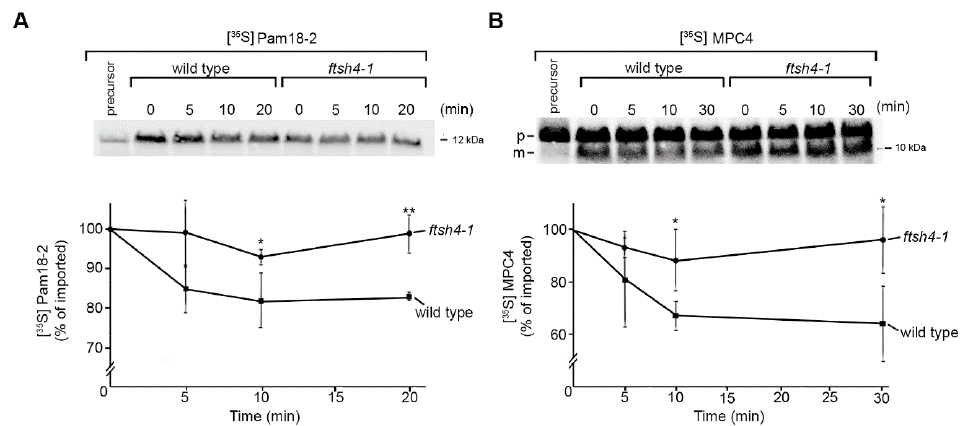
Figure 3. Novel proteolytic substrates of FTSH4 protease. ( A ) Degradation of Pam18-2 by FTSH4 following its in vitro import into mitochondria. Radiolabeled Pam18-2 was imported into mitochondria derived from either wild type or ftsh4-1 plants. The stability of newly imported precursor upon further incubation at 26 ◦ C was analyzed by SDS-PAGE and autoradiography. Quantification of [ 35 S] Pam18-2 in mitochondria is represented in the lower panel. Newly imported Pam18-2 was set to 100%. Data represent mean ± SD of three independent experiments. * p < 0.02 and ** p < 0.003 ( t -student test); ( B ) Degradation of MPC4 processed form by FTSH4 following its in vitro import into mitochondria. Radiolabeled MPC4 was imported into mitochondria derived from either wild type or ftsh4-1 plants. The stability of newly imported MPC4 upon further incubation at 26 ◦ C was analyzed by SDS-PAGE and autoradiography. Quantification of [ 35 S] MPC4 processed form in mitochondria is represented in the lower panel. Newly imported MPC4 was set to 100%. Data represent mean ± SD of three independent experiments. * p < 0.05 ( t -student test). m—MPC4 processed form, p—MPC4